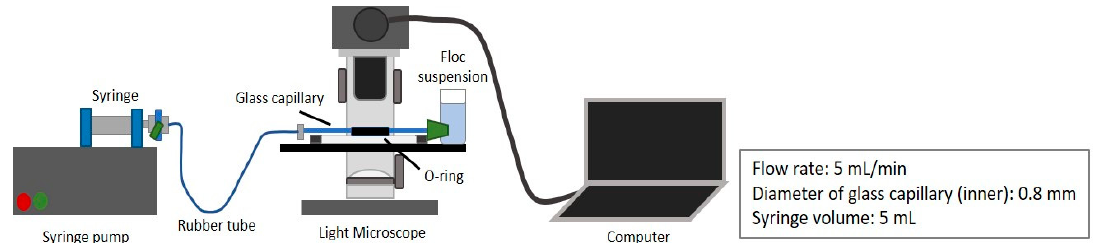
Figure 1. Schematic illustration of floc breakage experiment.